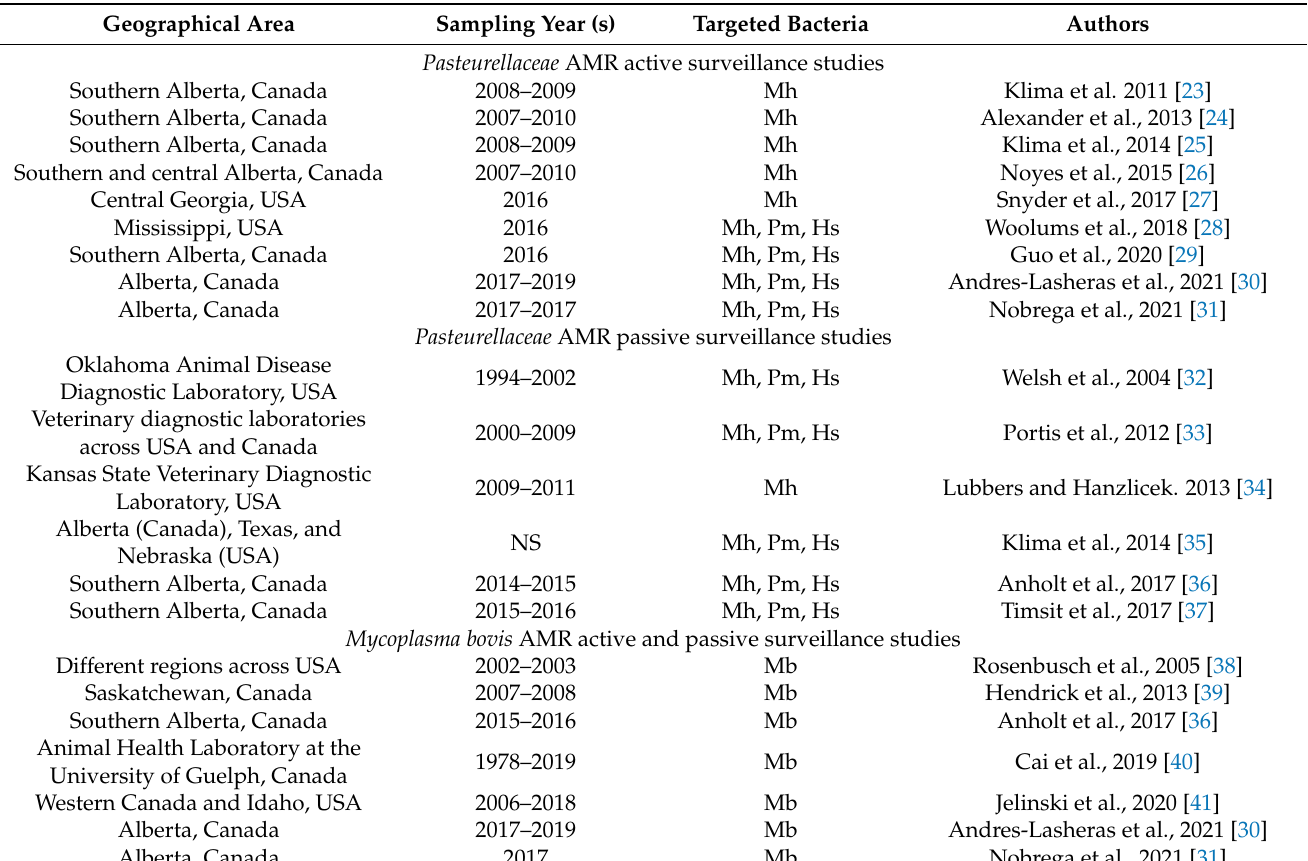
Table 1. Summary of the North American culture-dependent surveillance studies of bacteria associ- ated with bovine respiratory disease in beef cattle discussed in this review (see Section